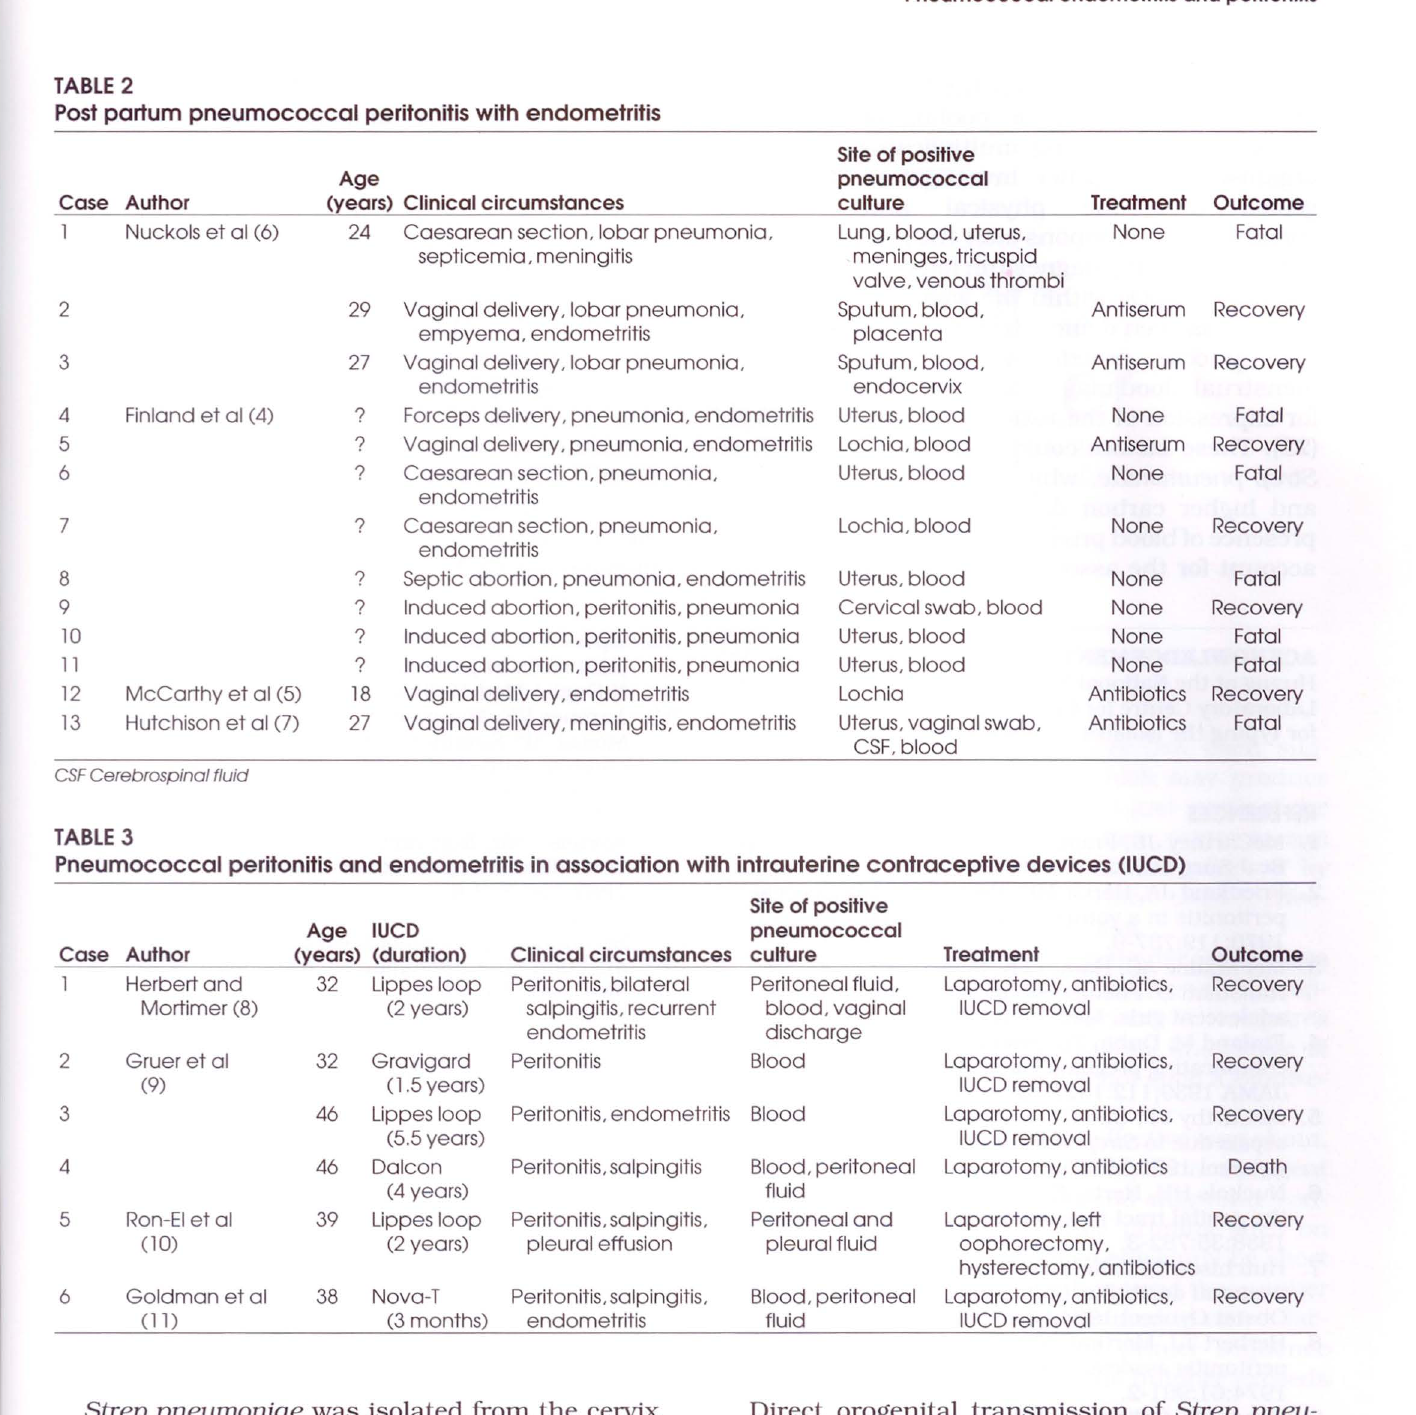
Post partum pneumococcal peritonitis with endometritis